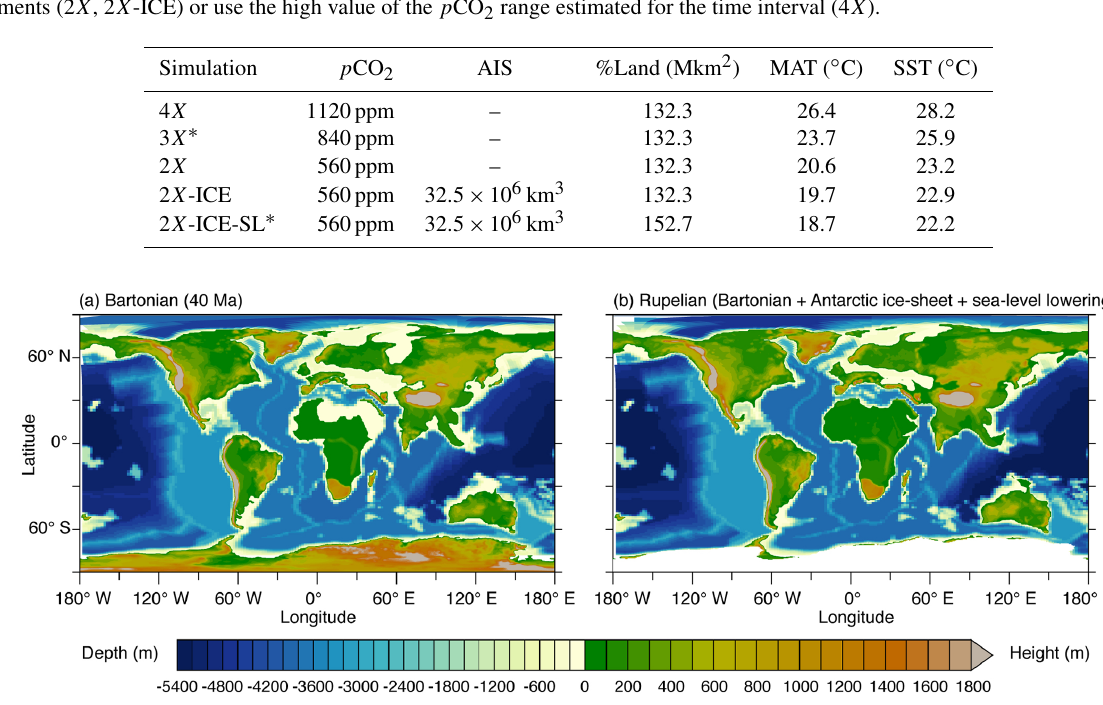
Figure 1. Paleotopographic 40Ma map: (a) standard version as used for simulations 4 X , 3 X , 2 X and 2 X -ICE; (b) version adjusted with a homogeneous 70m sea-level lowering used for the simulation 2 X -ICE-SL (Poblete et al.,